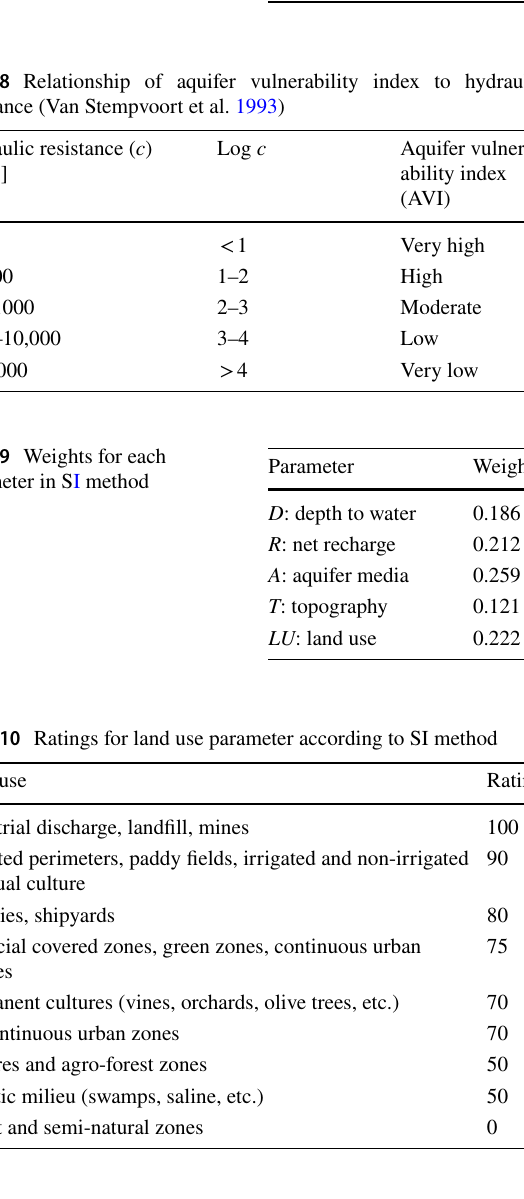
Table 7 Rating values of the hydraulic conductivity K